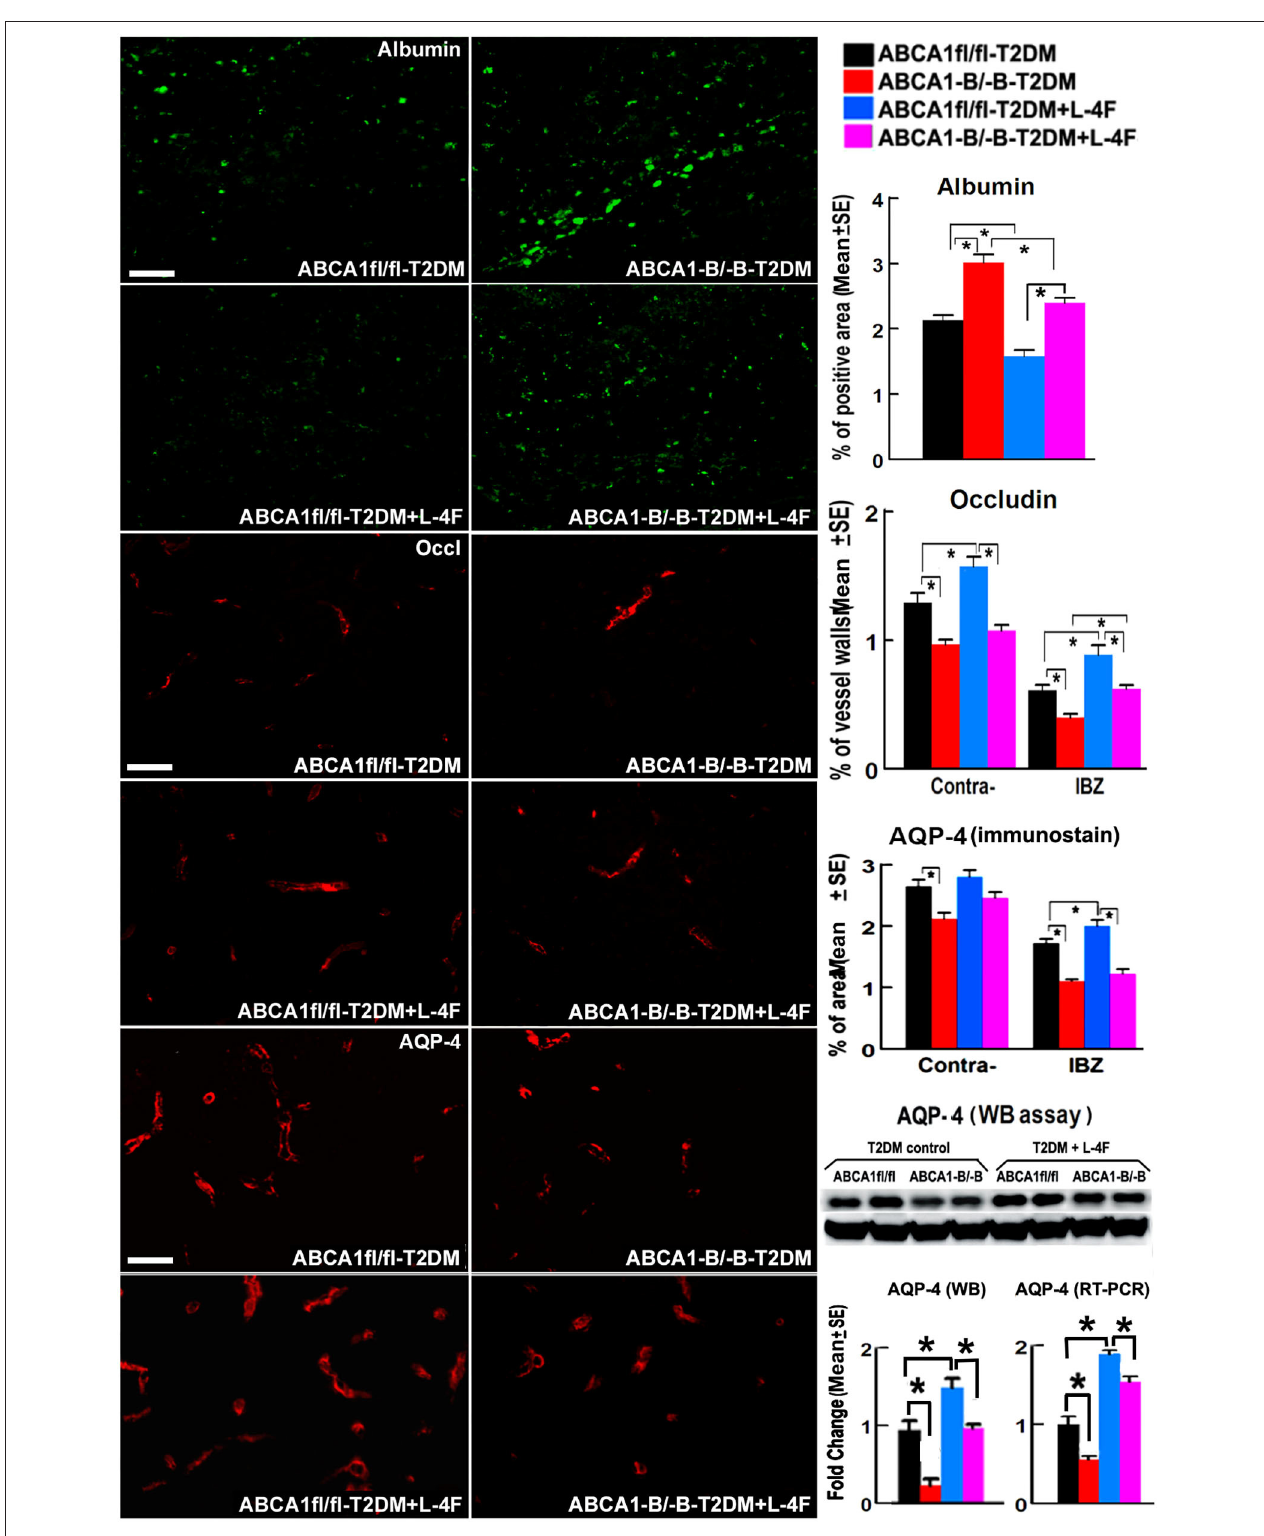
FIGURE 2 | L-4F treatment decreases BBB-leakage (albumin density) but increases tight-junction protein (Occludin) in the ischemic brain of T2DM mice at 21 days after stroke. L-4F treatment did not show an increases AQP-4 expression in astrocyte end-feet measured by immunostaining. However, the WB and RT-PCR data demonstrate that both the protein and mRNA level of AQP-4 in the ischemic brain was increased after 21 days of L-4F treatment. Scale bar = 50 µ m; * p < 0.05, n = 9/group in immunostaining measurement of Albumin, Occludin and AQP-4, n = 6/group in WB and RT-PCR assay.